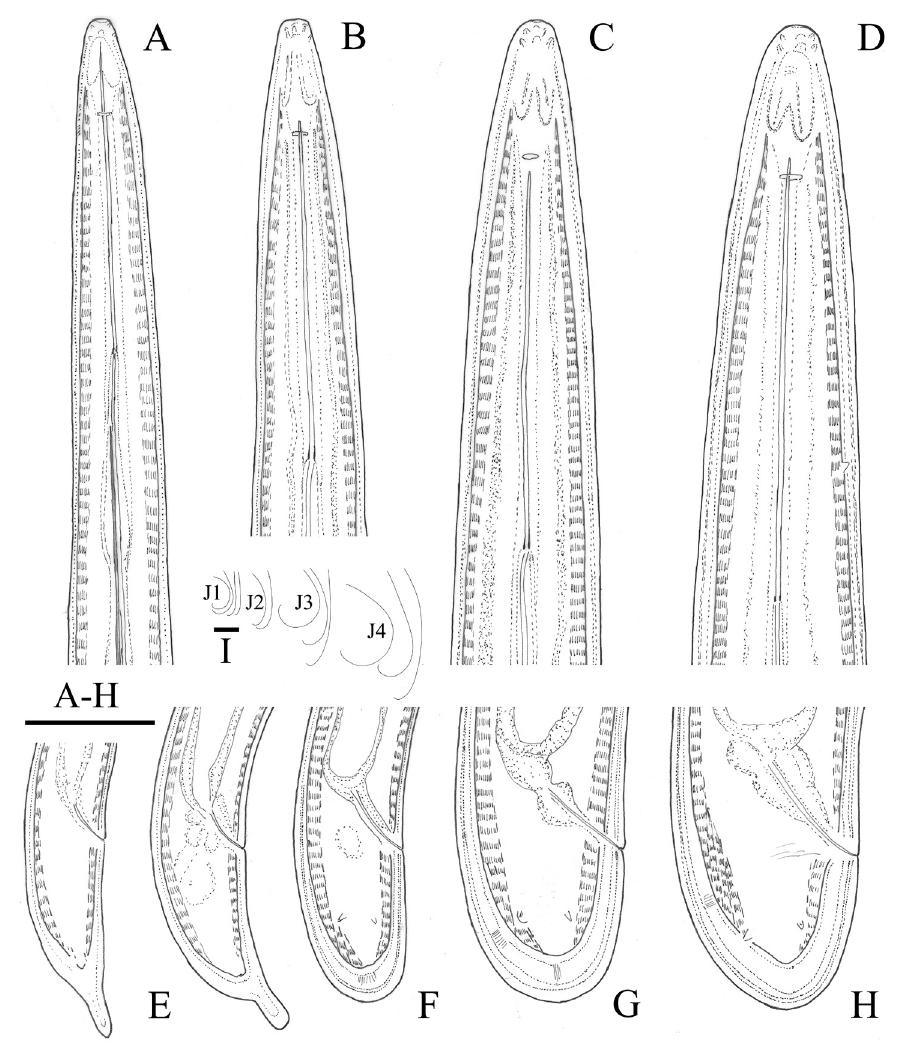
Figure 5. Longidorus polyae sp. n. A–D anterior end of first- (J1) to fourth- (J4) stage juveniles E–H tail of first to fourth juvenile stages I variations in J1-J4 habitus shapes. Scale bars: 25 μm ( A–H ); 1 mm ( I ).